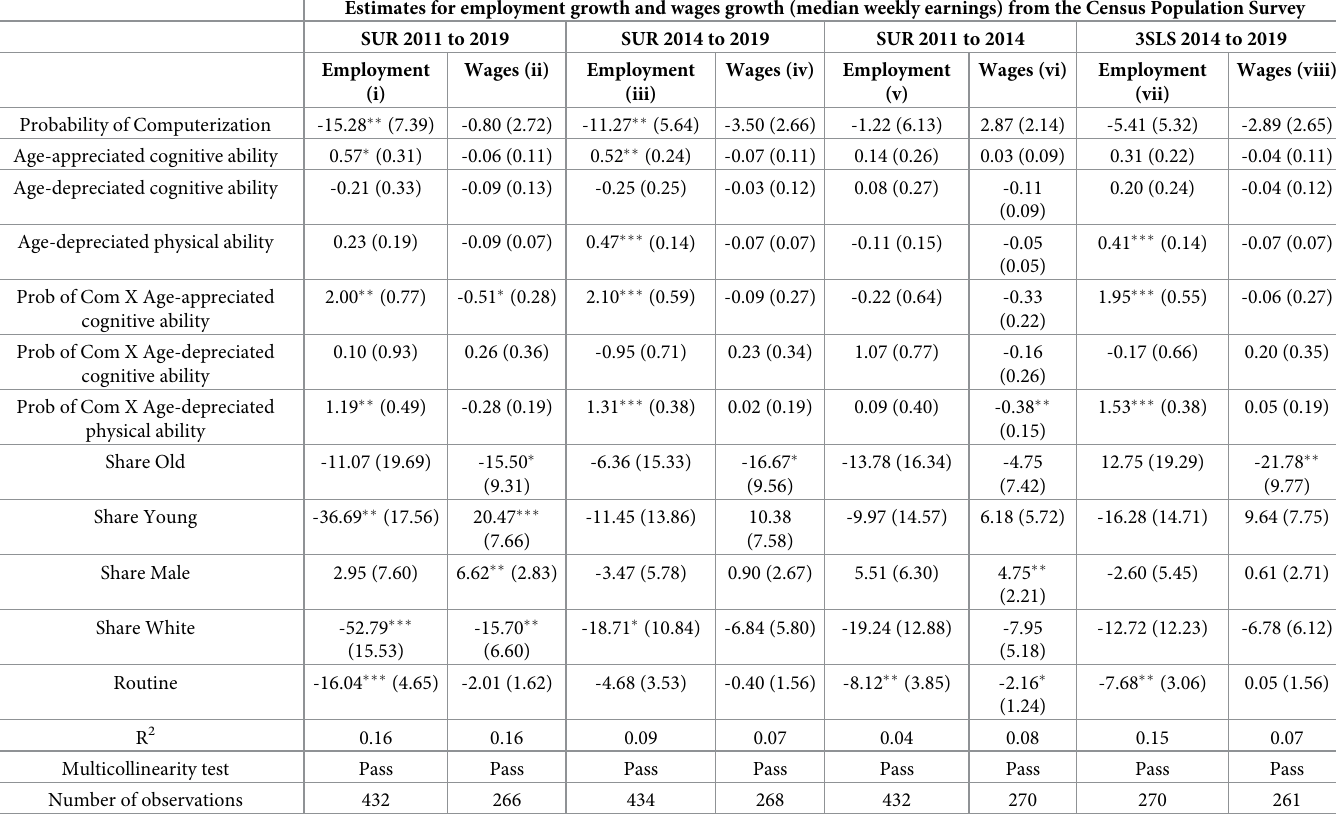
Table 5. Robustness analyses on the impact of the computerization and age-appreciation or age-depreciation on employment and wages (median weekly earnings) based on seemingly unrelated regression (SUR) and three stages least square